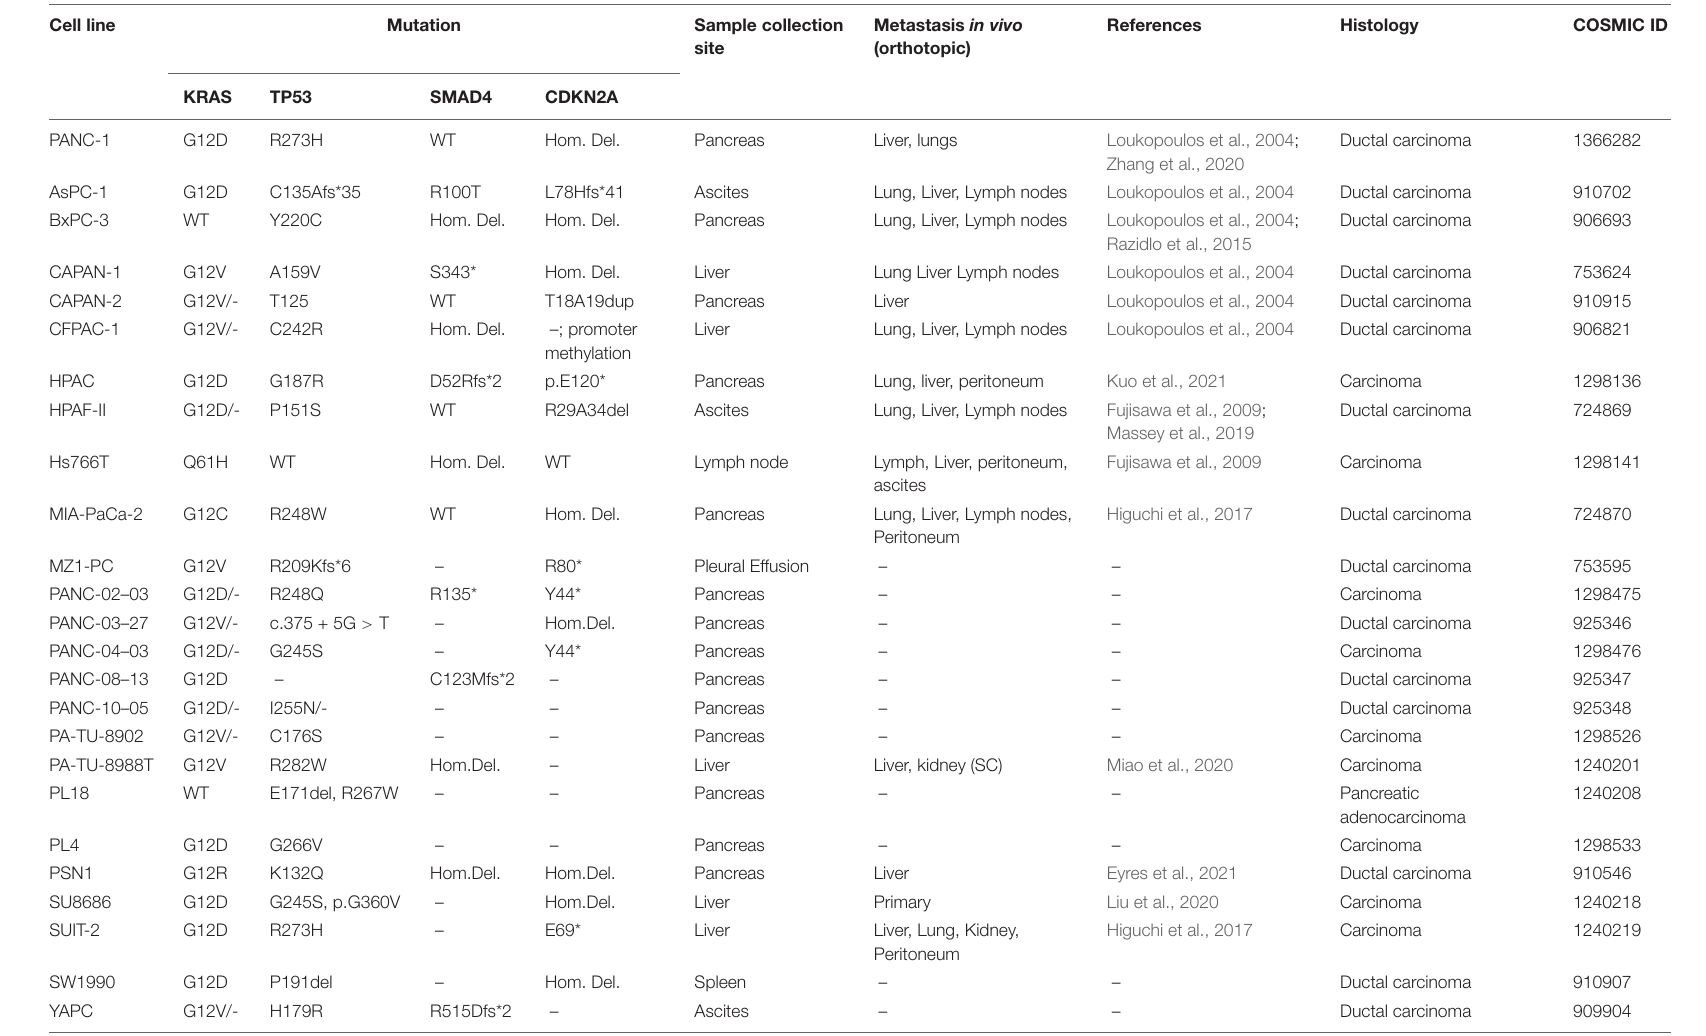
TABLE 2 | Most common Human derived pancreatic cancer cell lines and metastatic activity in orthotopic transplantation